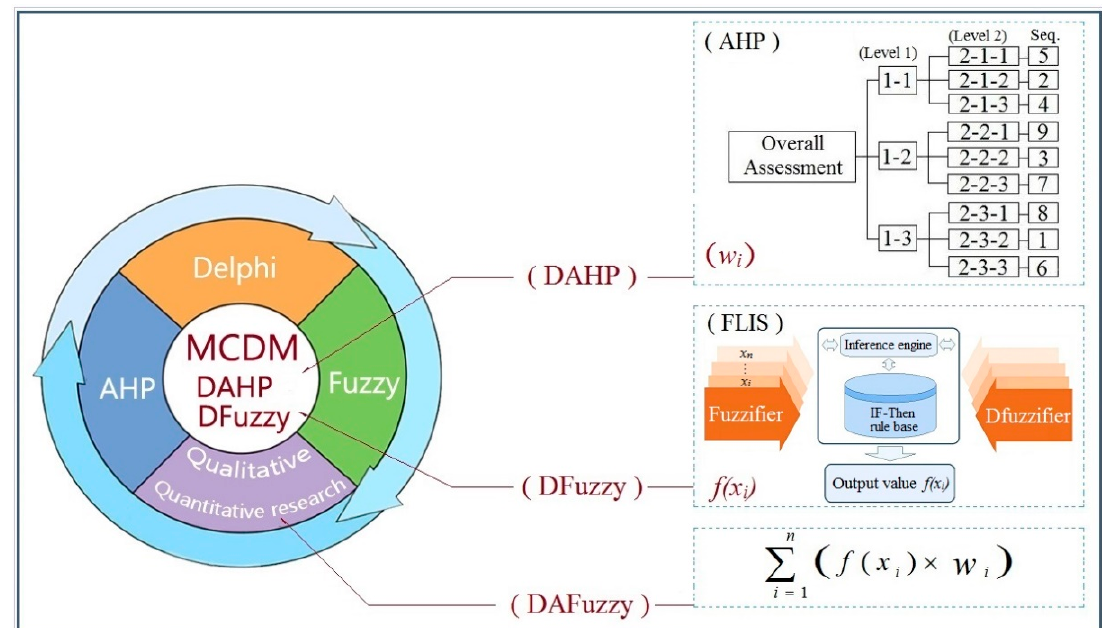
Figure 5. Architecture of DAFuzzy model.